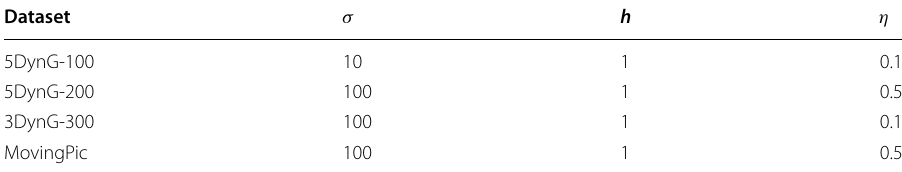
Table 2 Hyperparameters for graphKKE used in the comparative analysis in Sect. 5.3, where σ is the bandwidth, h the number of iterations, and η the regularization parameter Dataset